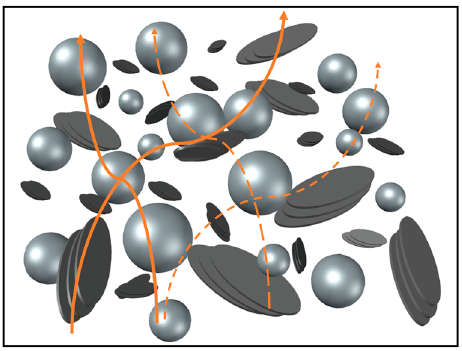
Figure 6. Schematic representation of the conductive paths (orange lines) in the HDPE hybrid filler system; the silver spheres represent the Al 2 O 3 particles, while the different platelet particles represent the stacked layers of graphene; the big particles being EG and the small particles being G.